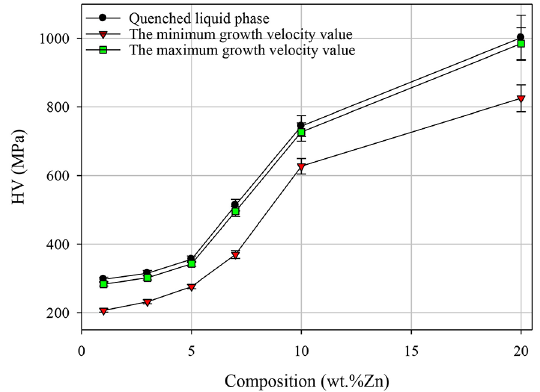
Figure 8. The variation of measured microhardness with composition for quenched liquid and solid phases obtained with the maximum and minimum growth